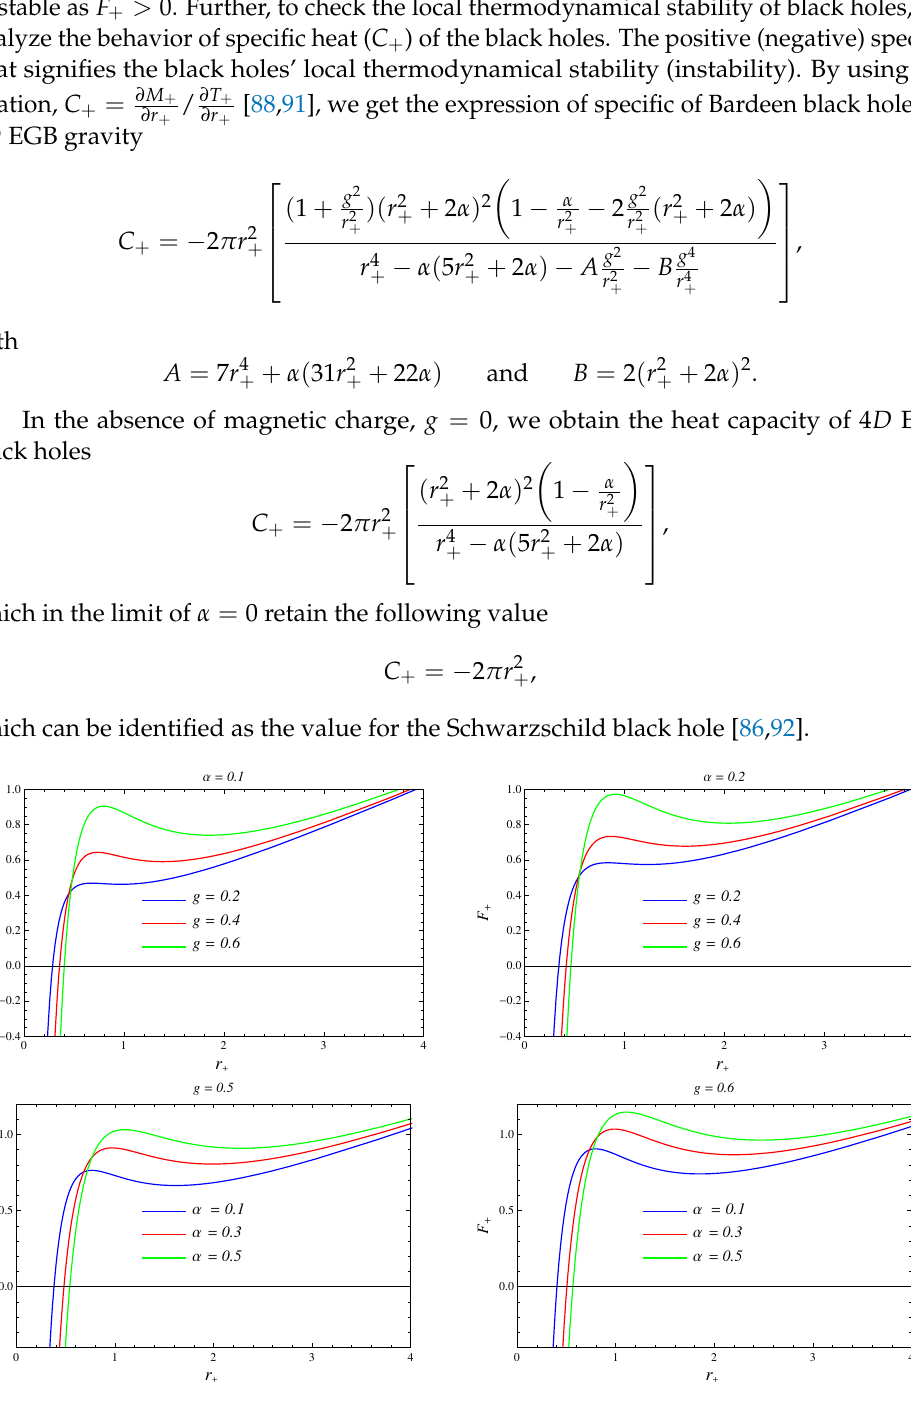
Figure 3. The Helmholtz free energy F + vs horizon r + for different values of g and α